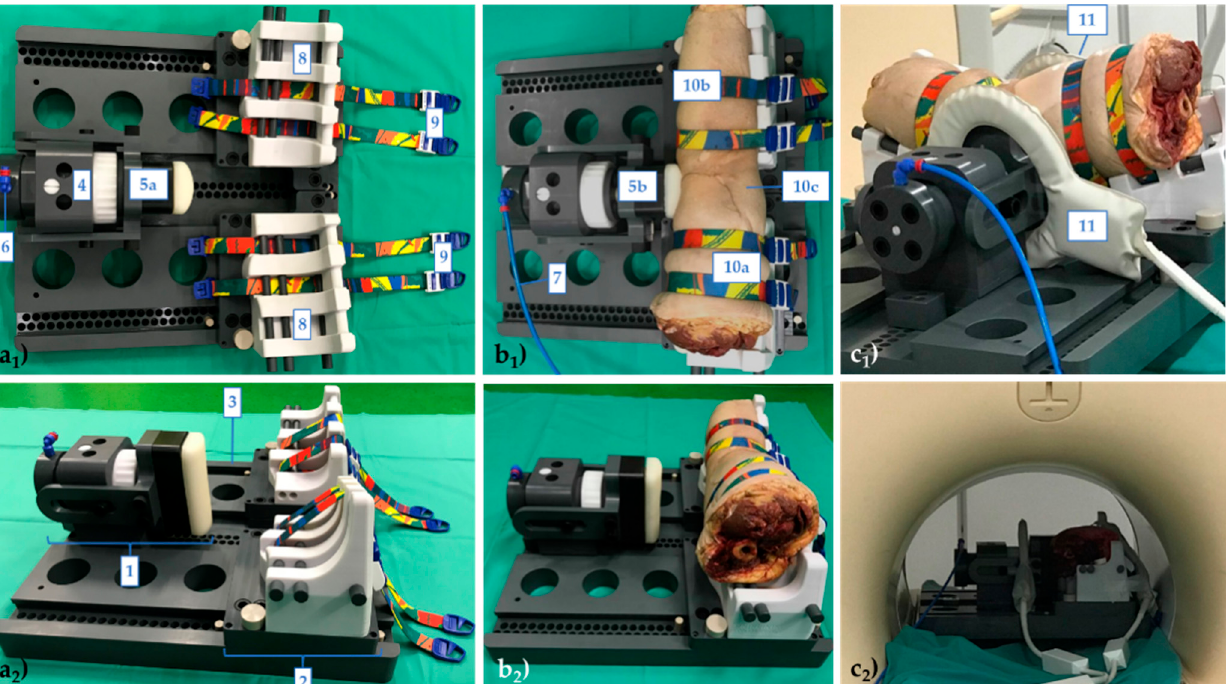
Figure 1. Experimental setup used for in-situ imaging of knee joints under valgus loading. Top ( a 1 , b 1 ) and side views ( a 2 , b 2 ) of the loading device without ( a ) and with ( b ) a representative (right-sided) knee joint. The loading device consists of a loading (1) and holding unit (2) that are both attached to the rigid base plate (3). The pneumatic unit (4) actuates the padded load applicator (5a—not pressurized, 5b—pressurized) which is aligned along the joint line and connected to the in-house pressure supply via a pressure port (6) and respective pressure lines (7). The holding unit standardizes joint position at 30° of flexion by two quarter-pipe wedges (8). Fixation is provided by two tourniquets (9) at the level of the thigh (10a) and lower leg (10b), while the popliteal fossa (10c) is not fixed. Fully operational setup with two flexible dual-coils positioned in lateral orientation to the knee (11) outside ( c 1 ) and inside ( c 2 ) a clinical 3.0T-MRI scanner.